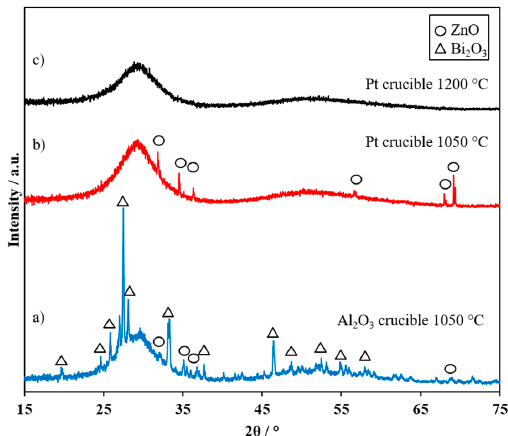
Figure 2. X-ray diffraction patterns of solidified Bi 2 O 3 -Li 2 O-ZnO glass melted in (a) an Al 2 O 3 crucible at 1050 °C, (b) in a Pt crucible at 1050 °C, and (c) in a Pt crucible at 1200 °C. The reflexes are assigned to Bi 2 O 3 (ICDD-PDF-4-2018-04-011-1986) and ZnO (ICDD-PDF-4-2018-01-070-8070).